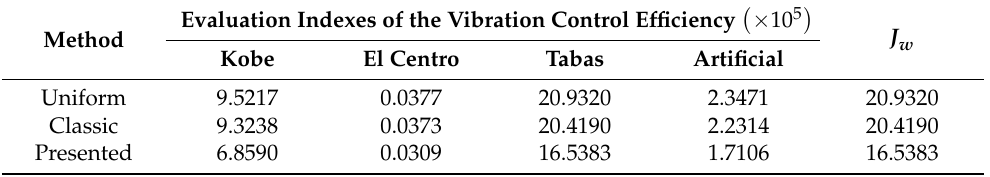
Table 8. Evaluation indexes of the vibration control efficiency under different seismic